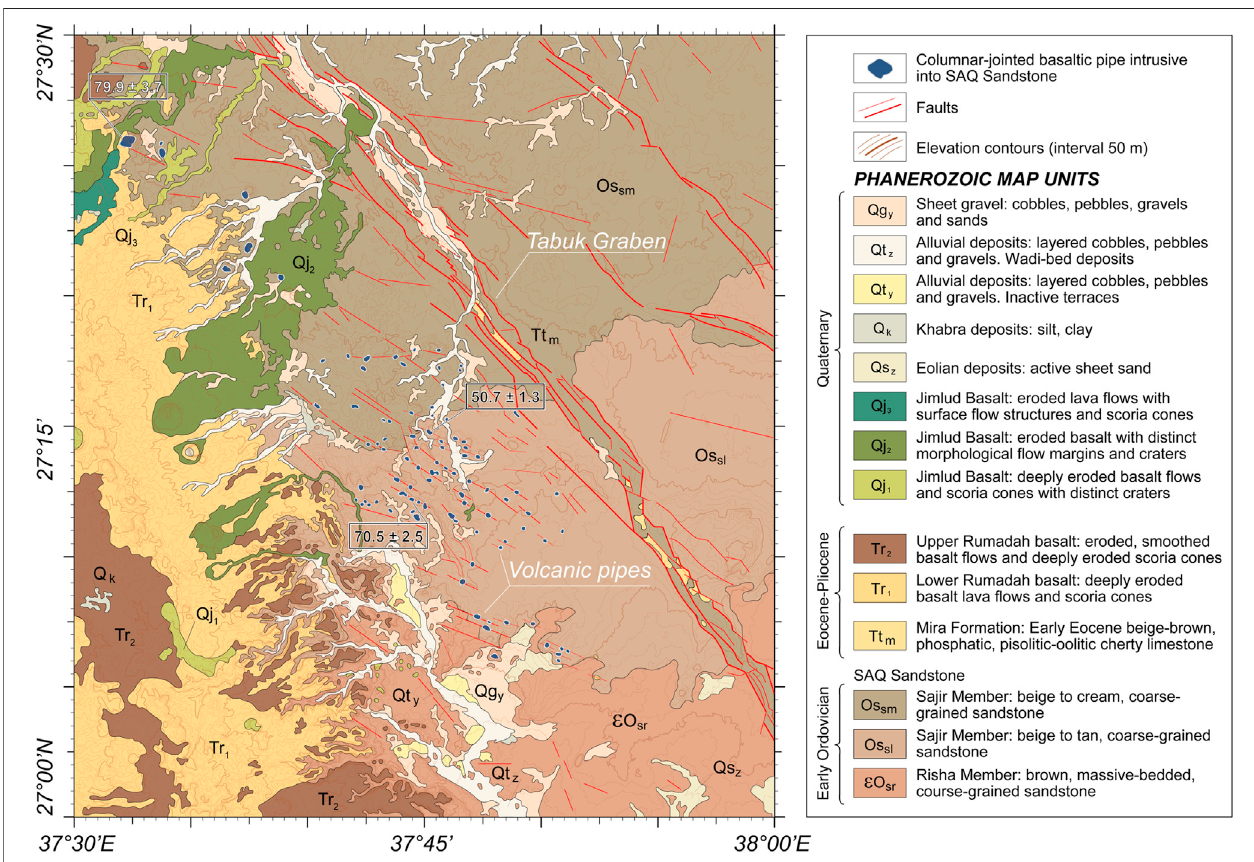
FIGURE 2 | Geological setting of the study area redrawn from the Geological Map of the Tayma Quadrangle, Sheet 27 ° C, Scale 1:250,000 published by the Saudi Geological Survey (Vaslet et al., 1994). Mercator projection at 27 ° N, datum WGS84. K-Ar radiometric ages of dated volcanic pipes are also indicated within black